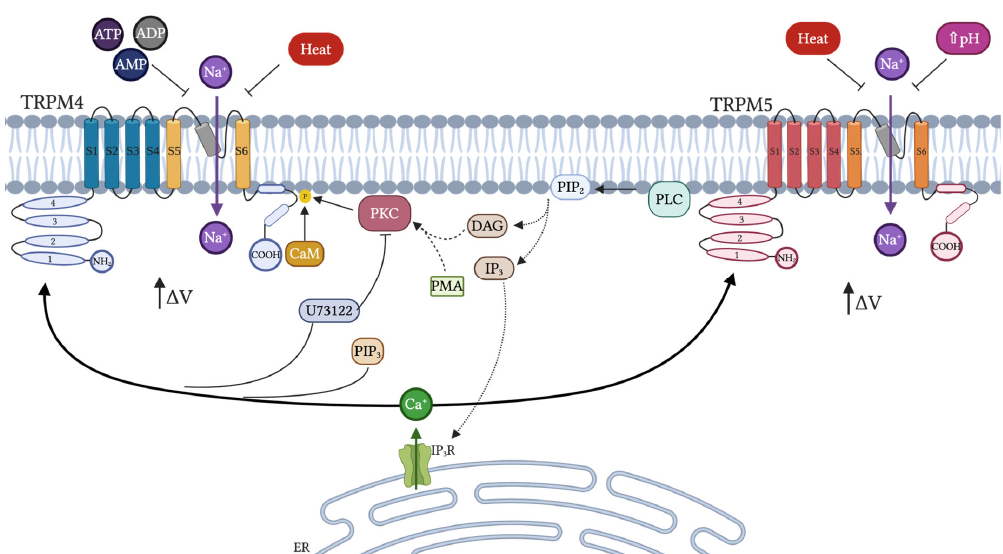
Figure 4. Endogenous regulation of TRPM4 and TRPM5. Both TRPM4 and TRPM5 are activated